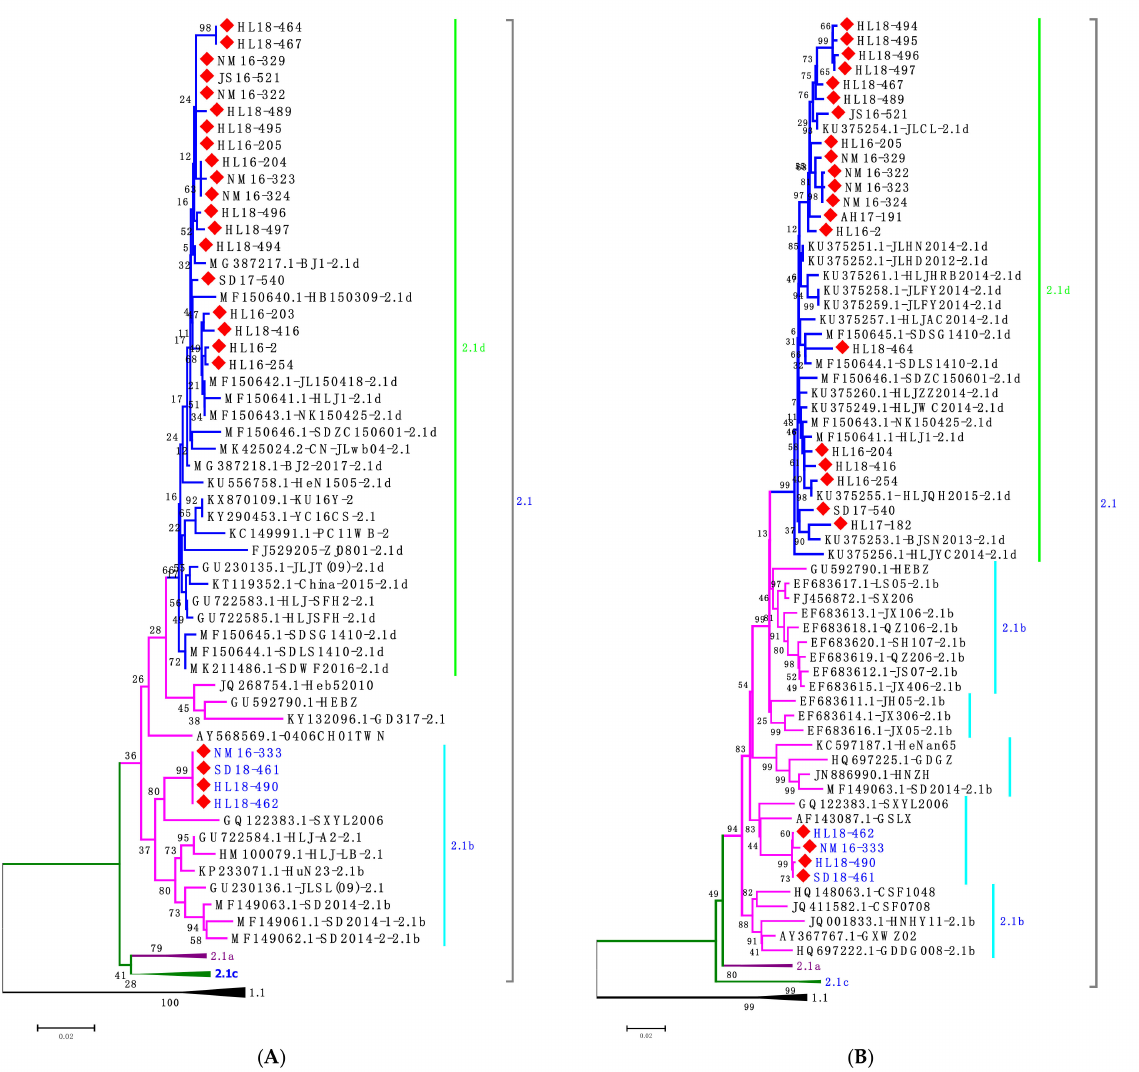
Figure 2. Phylogenetic tree based on nucleotide sequences of NS5B and E2. ( A ) Phylogenetic analysis of the 23 new isolates and 46 reference strains based on partial NS5B gene. ( B ) Phylogenetic analysis of the full-length E2 genes of the 24 new isolates with comparison of 47 reference strains. The trees were constructed using the neighbor-joining (NJ) method, with 1000 bootstrap replicates. The new CSFV isolates were denoted by red diamonds, in which, subgenotype 2.1b isolates were indicated in